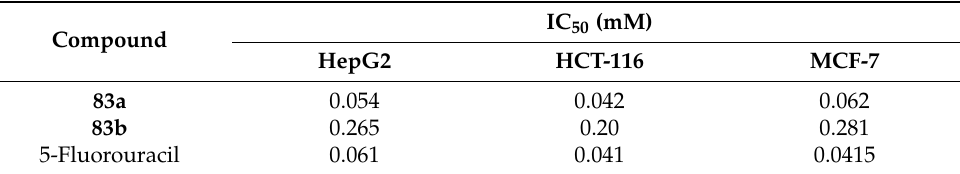
Table 13. In vitro antitumor activity of the compounds 83a – 83b toward Hep-G2, HCT-116 and MCF-7 cancer cell